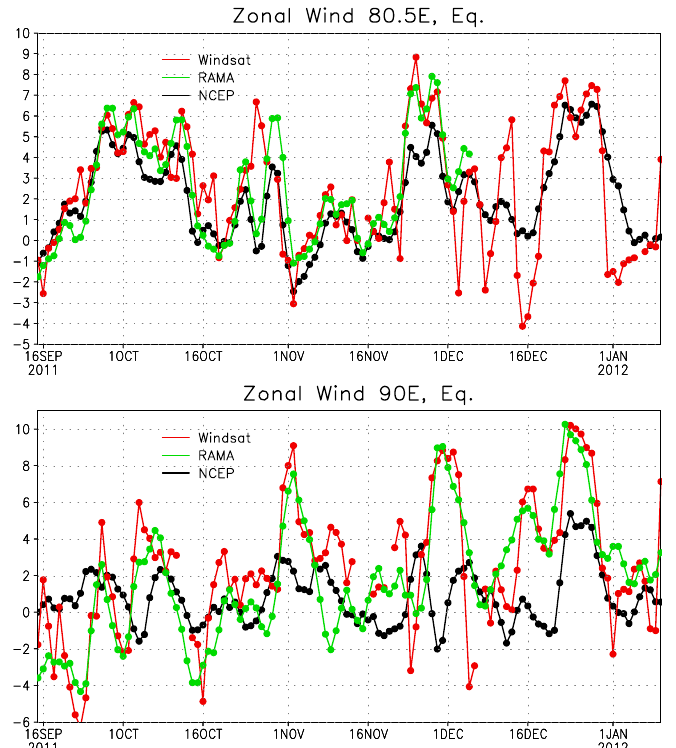
Figure 2. ( Upper ): 3-day average zonal winds (m/s) at 10 m height at 80.5°E, equator from Windsat (red), RAMA buoy (green), and the NCEP/NCAR reanalysis (black). ( Lower ): Same as upper panel except at 90°E,